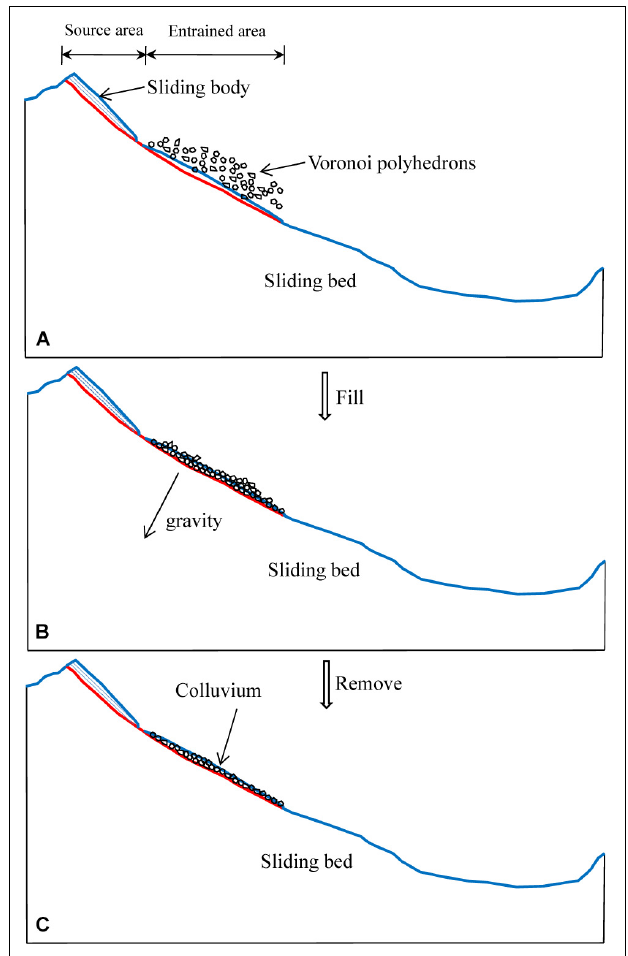
FIGURE 8 | The process of generating colluvium in 3DEC showed in 2D: (A) generate Voronoi polyhedrons enough to fill the entrained area above the slope surface; (B) Voronoi polyhedrons fall into the entrained area under gravity while the sliding bed is fixed; (C) remove blocks above the surface before sliding. The blue lines and red lines represent the slope surface before and after sliding, respectively. The gravity direction is perpendicular to the slope surface of the entrained